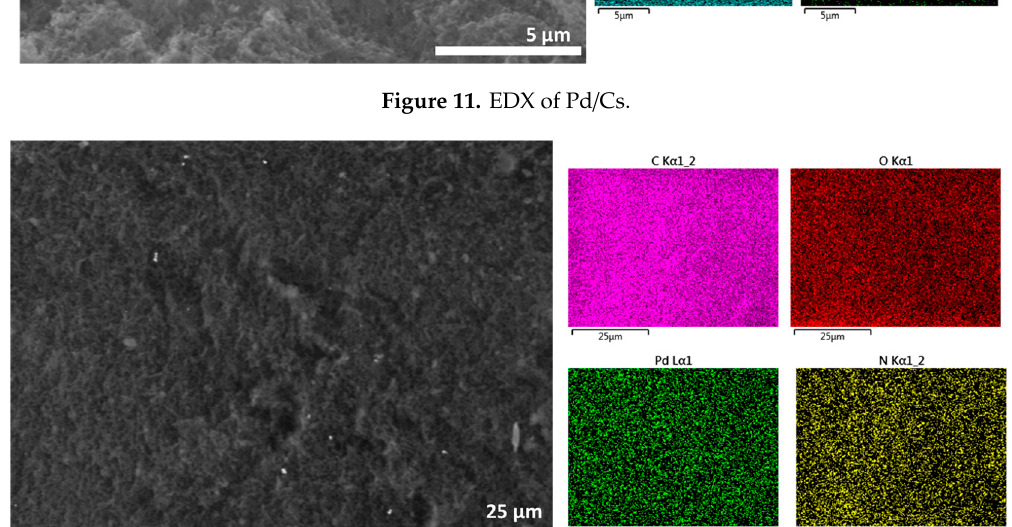
Figure 12. EDX of Pd/CS-GO1.